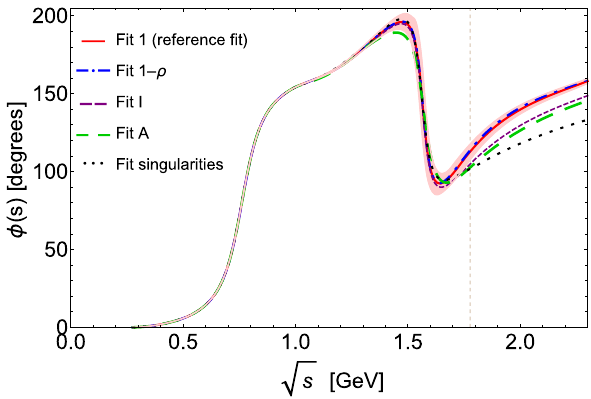
Fig. 4 Results for the form factor phase shift as extracted from our reference fit in Table1, Fit 1 (solid red curve), and from Fit 1- ρ at the matching point of 0.85 GeV (dot-dashed blue curve), Fit I (short dashed purple curve), Fit A (long dashed green curve) and with the fit thatavoidssingularities(dottedblackcurve).Theverticaldashedbrown line is placed at m τ and denotes the validity of the parametrization of the form factor phase shift. All phases are smoothly guided to π for s > m τ . See main text for details